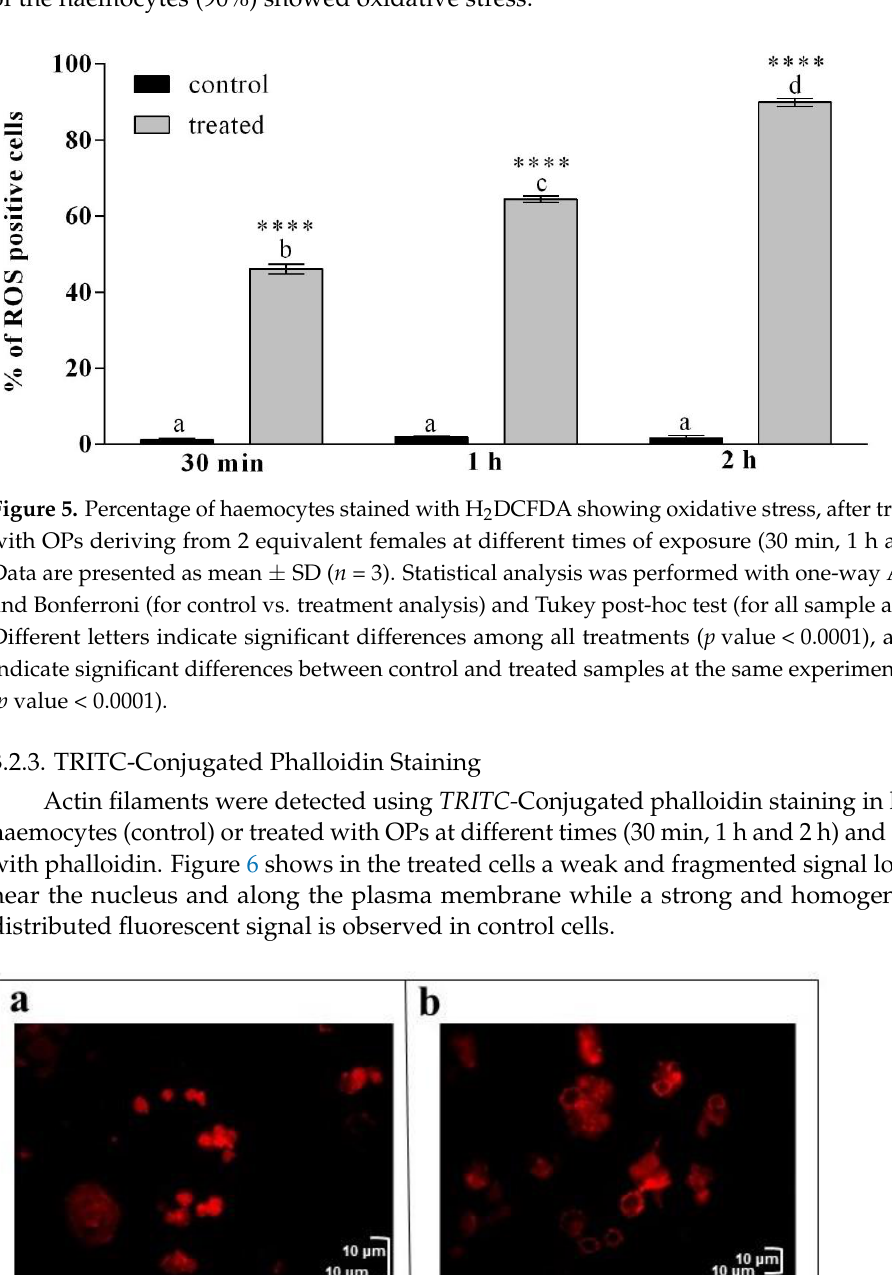
Figure 4. Healthy in vitro haemocytes ( a ) or treated with OPs for 2 h ( b ) and stained with 2,7 di- chlorodihydrofluorescein acetate (H 2 DCFDA). Red box = enlargement of cells below. Scale bar 10 μm.